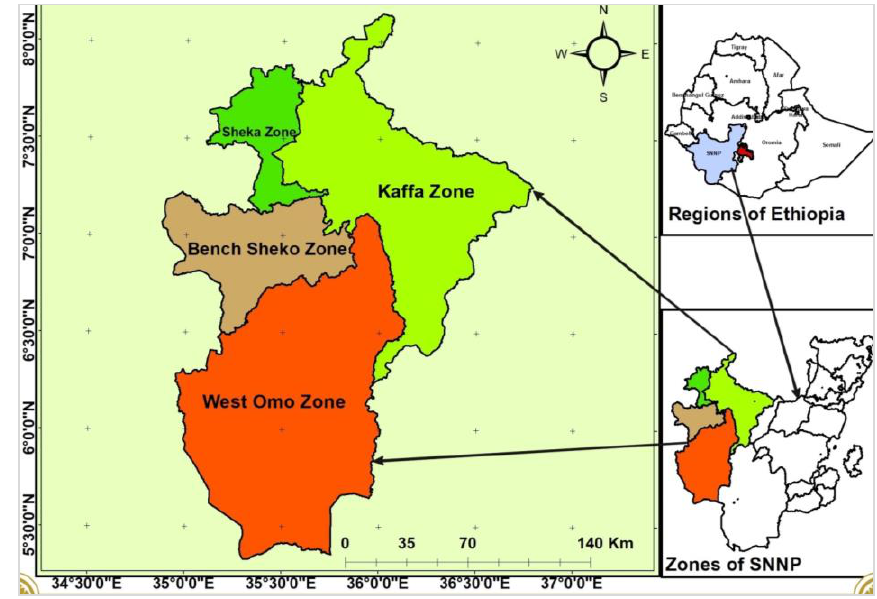
Fig. 2. Map of the study area